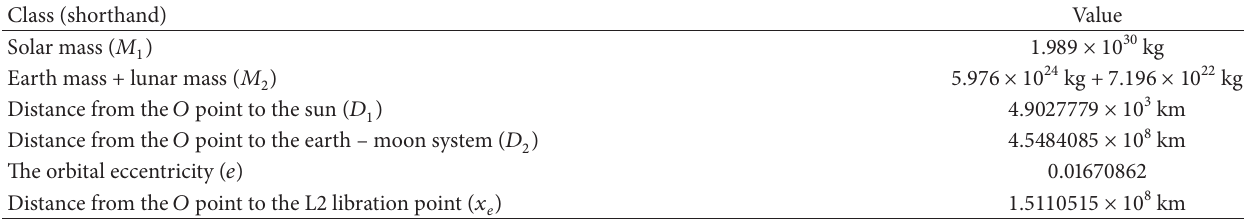
Table 1: Basic constants of L2 point in the sun-earth system.